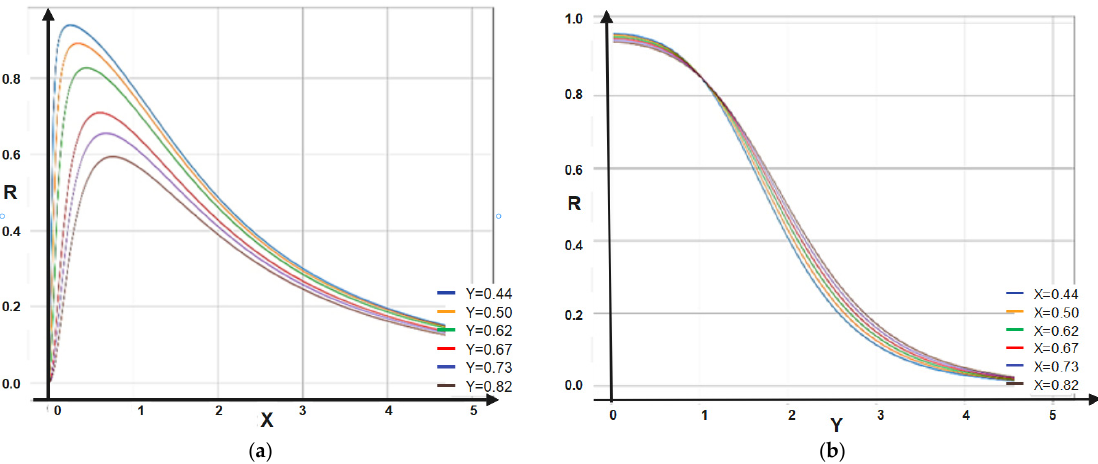
Figure 5. ( a , b ) The 2D dependencies of R = R (X, Y): ( a ) R = R (X, Y = constant); ( b ) R = R (X = constant, Y).